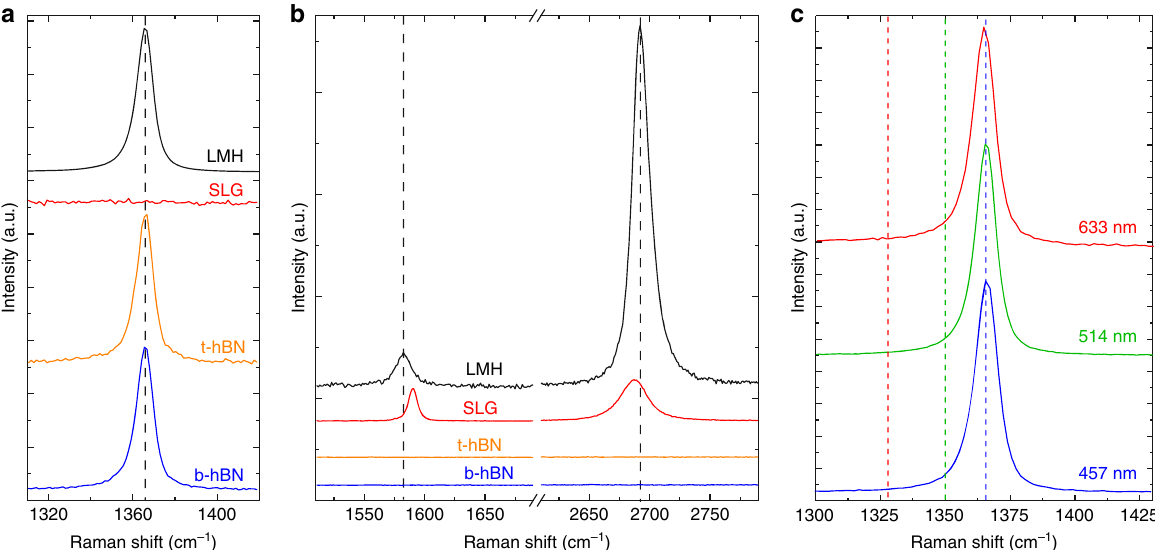
Fig. 5 Raman spectra before and after heterostructure assembly. The bottom hBN fl ake (b-hBN) is shown in blue, the top hBN fl ake (t-hBN) in orange, the SLG fl ake in red, and the assembled heterostructure in black. a hBN E 2g spectral region. The measured spectra are normalized to the height of the E 2g peak. b G and 2D peak spectral region. The spectra containing SLG peaks are normalized to the height of the G peak. The spectra associated with t-hBN and b- hBN have the same scaling as in a. The E 2g , G and 2D peaks after encapsulation are marked by dashed black lines. Spectra in a and b are acquired at 514 nm. c Raman spectra measured at 457, 514, and 633 nm. The expected Pos(D) at 457, 514, and 633 nm are shown by dashed lines in blue, green and red, respectively. The spectra are normalized to the height of the 2D peak